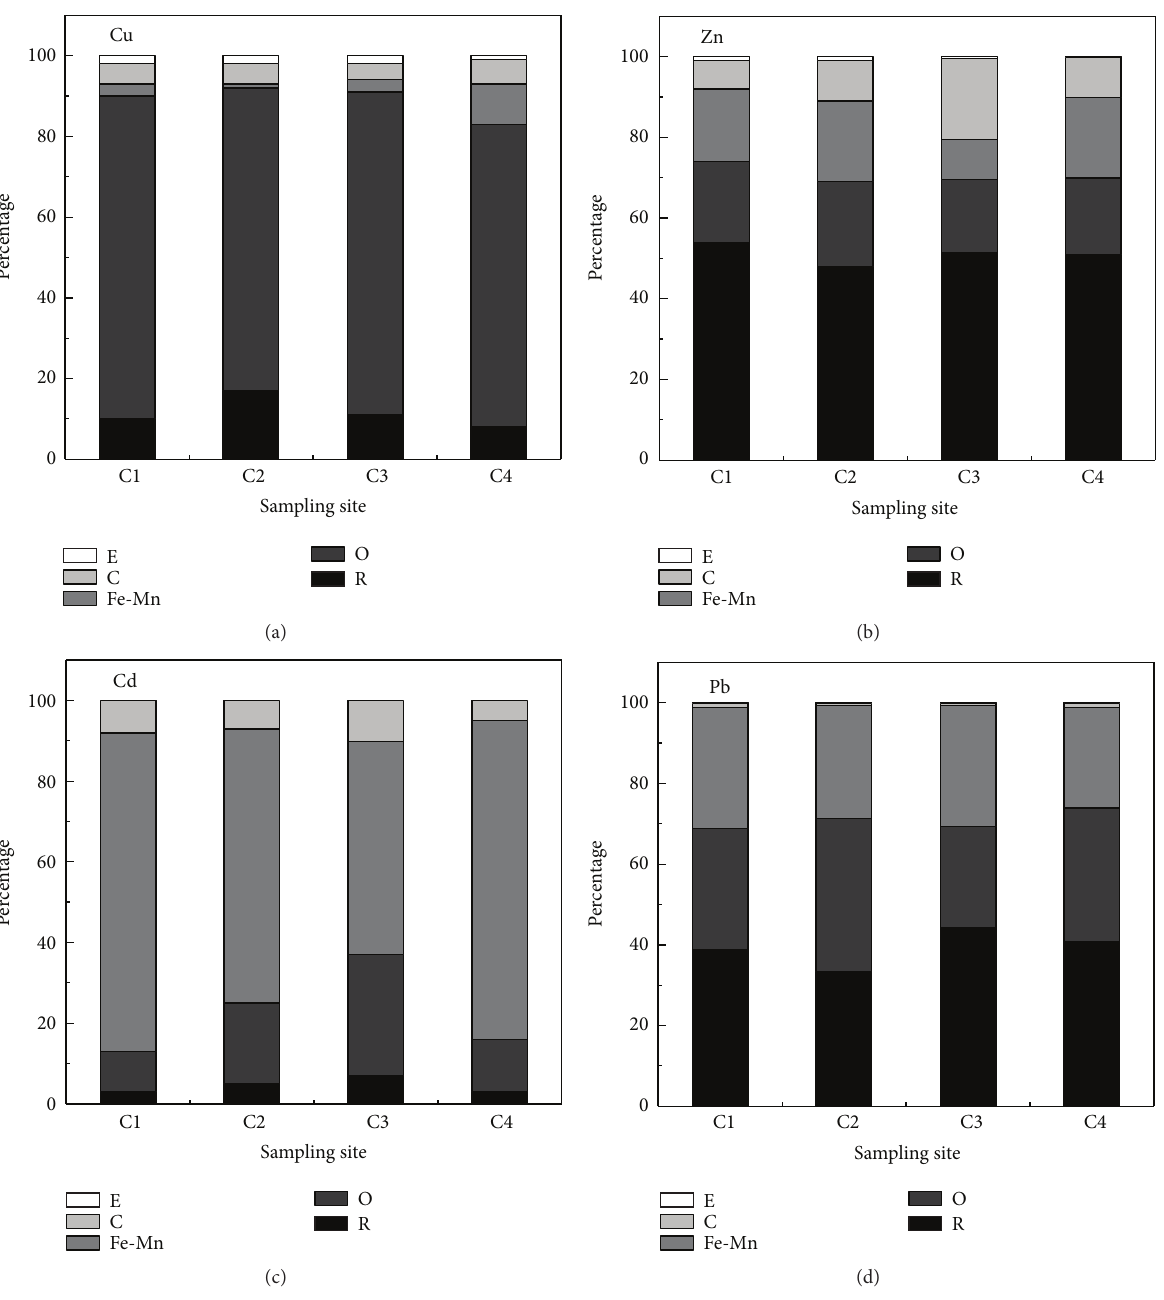
Figure 5: The fractionation distribution of metals Cu, Zn, Cd, and Pb at Chegongzhuang Street. Note: E, C, Fe-Mn, O, and R represent exchangeable fraction, carbonate bound fraction, Fe-Mn oxide bound fraction, organically bound fraction, and residual fraction, respectively.